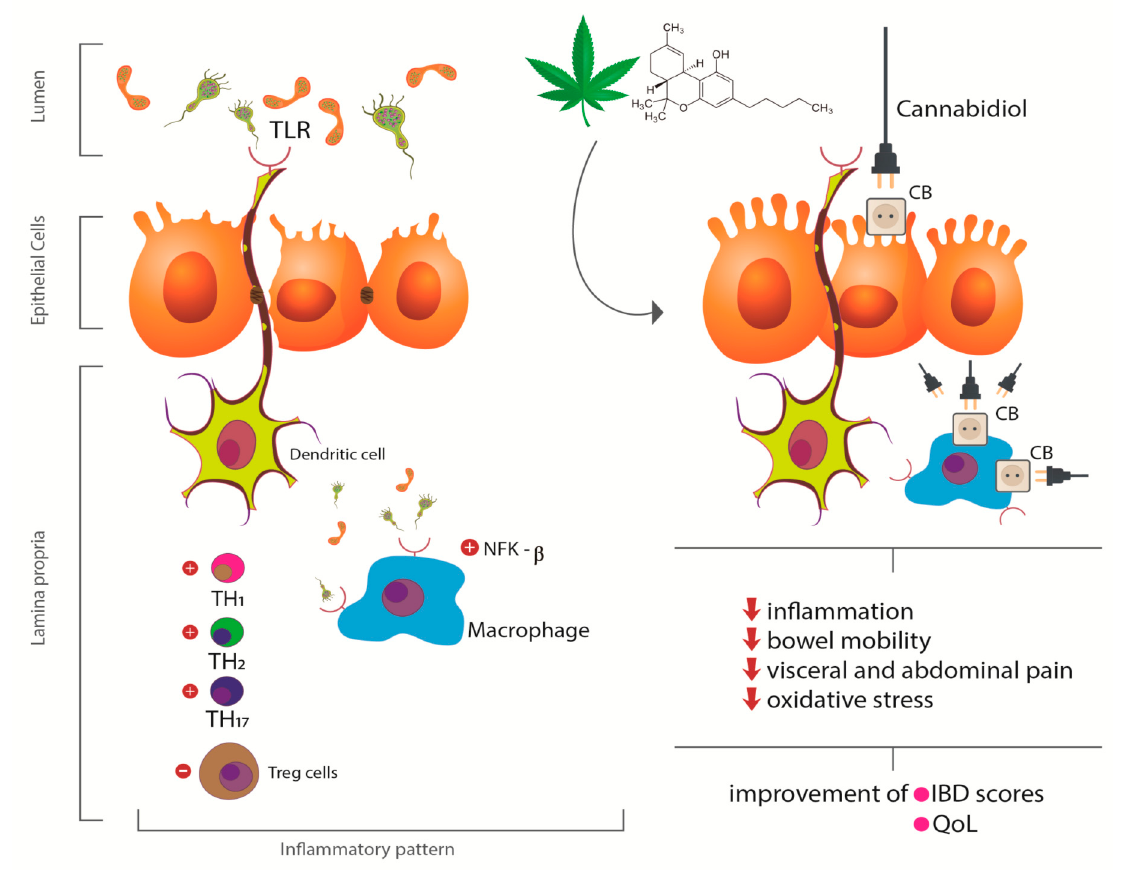
Figure 3. Effects of Cannabis sativa or its derivatives in the pathophysiologic aspects of IBD. When acting on peripheral CB receptors, canabidiol decreases the inflammatory response by decreasing TLR and NFK- β activation, reduces the generation of free radicals and oxidative stress, and reduces intestinal motility leading to consequent improvement in quality of life. TLR: Toll like receptor; CB: canabidiol receptor; NFk- β : nuclear factor kappa-beta; TH: T helper cell; Treg: T regulatory cells; IBD: inflammatory bowel diseases; QoL: quality of life.